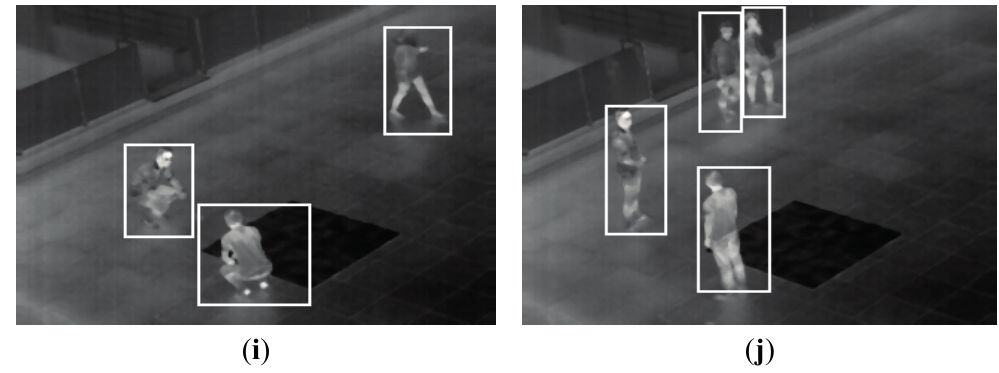
Figure 13. Detection results with the OTCBVS benchmark dataset ( a – f ) and our